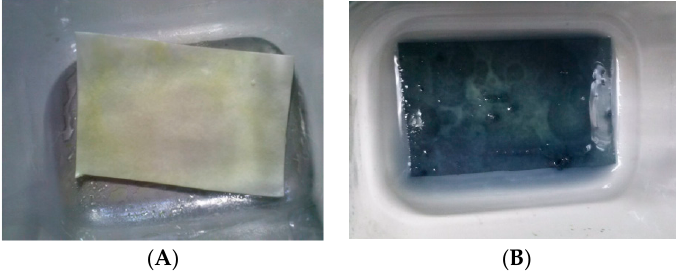
Figure 6. Folin-Ciocalteau staining of tissue paper filters after complete nebulization of CM-glucan formulations in the absence ( A ) or presence ( B ) of resveratrol.